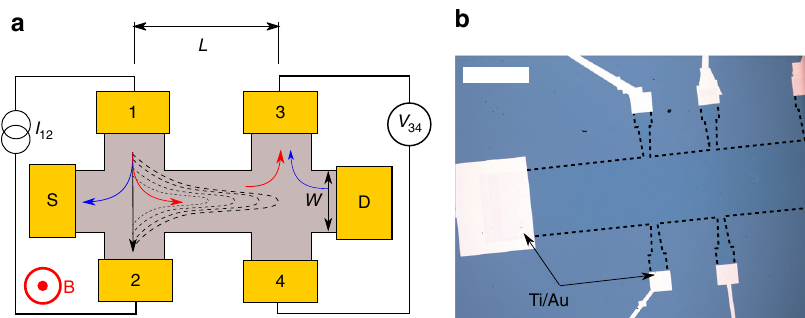
Fig. 1 Device structure and nonlocal measurements. a Sketch of the Hall-bar-shaped channel for nonlocal measurements. The nonlocal measurement consists of driving a current (black arrow) across contacts 1 and 2, and measuring the resulting voltage signal between probes 3 and 4. The nonlocal resistance is de fi ned as R NL = V 34 / I 12 . In the spin Hall regime, a spin current transverse to the injected charge current is generated via SHE (spin “ down ” , blue arrow; spin “ up ” , red arrow), and diffuses through the channel of length L until it reaches electrodes 3 and 4, where via ISHE the spin current generates a charge current. The black dashed lines represent the van der Pauw contribution to the nonlocal resistance detected between probes 3 and 4. This background signal originates from the current spreading from terminals 1 and 2, and depends only on the resistivity of the conducting channel multiplied by an exponential decaying geometrical factor. In our devices, the current is always injected in the left arm, and detected at the right arm, with the external magnetic fi eld applied perpendicular to the surface. b Optical microscope image of the macroscale CVD graphene sample. The channel width, W , is 500 μ m, with the electrodes distance L being 500, 700, 900, 1200, and 1500 μ m. The width of the contacts is de fi ned to be 1/10th of the width of the channel. White scale bar is 500 μ